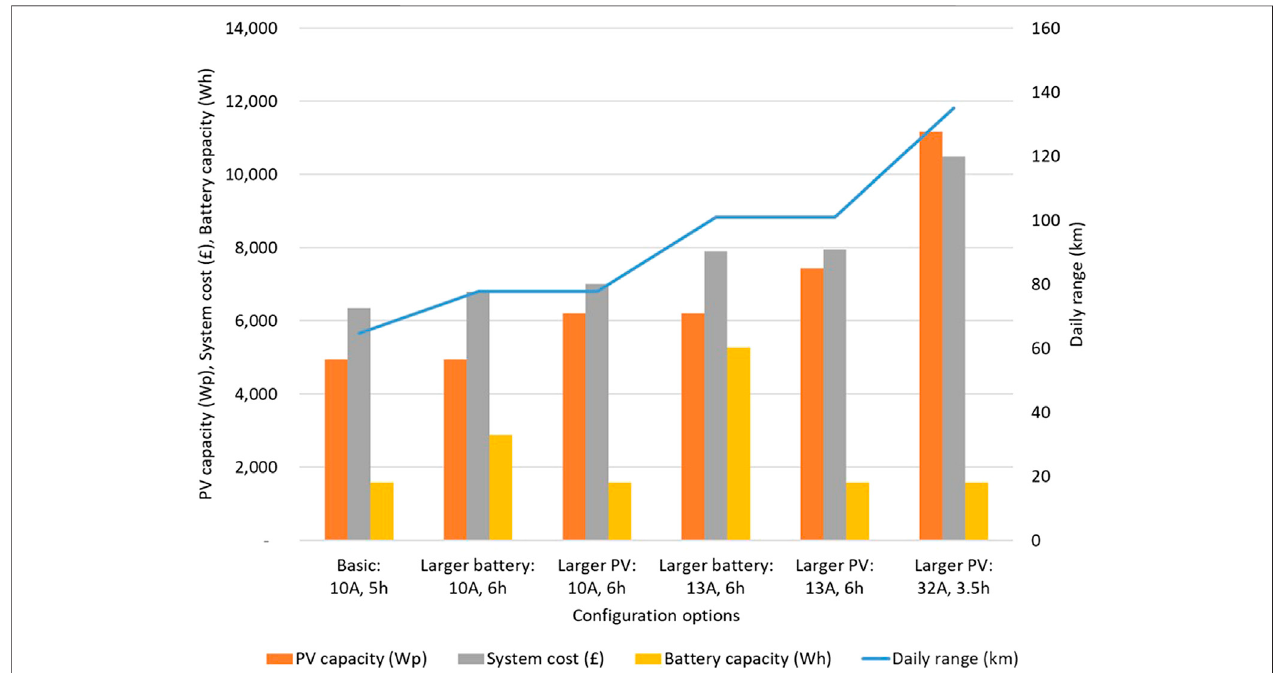
FIGURE 11 | Different PV system con fi gurations are assessed for commercial viability. For each, the mean daily EV range achievable is based on the Nissan e-NV200 used in the Solar Taxi pilot.